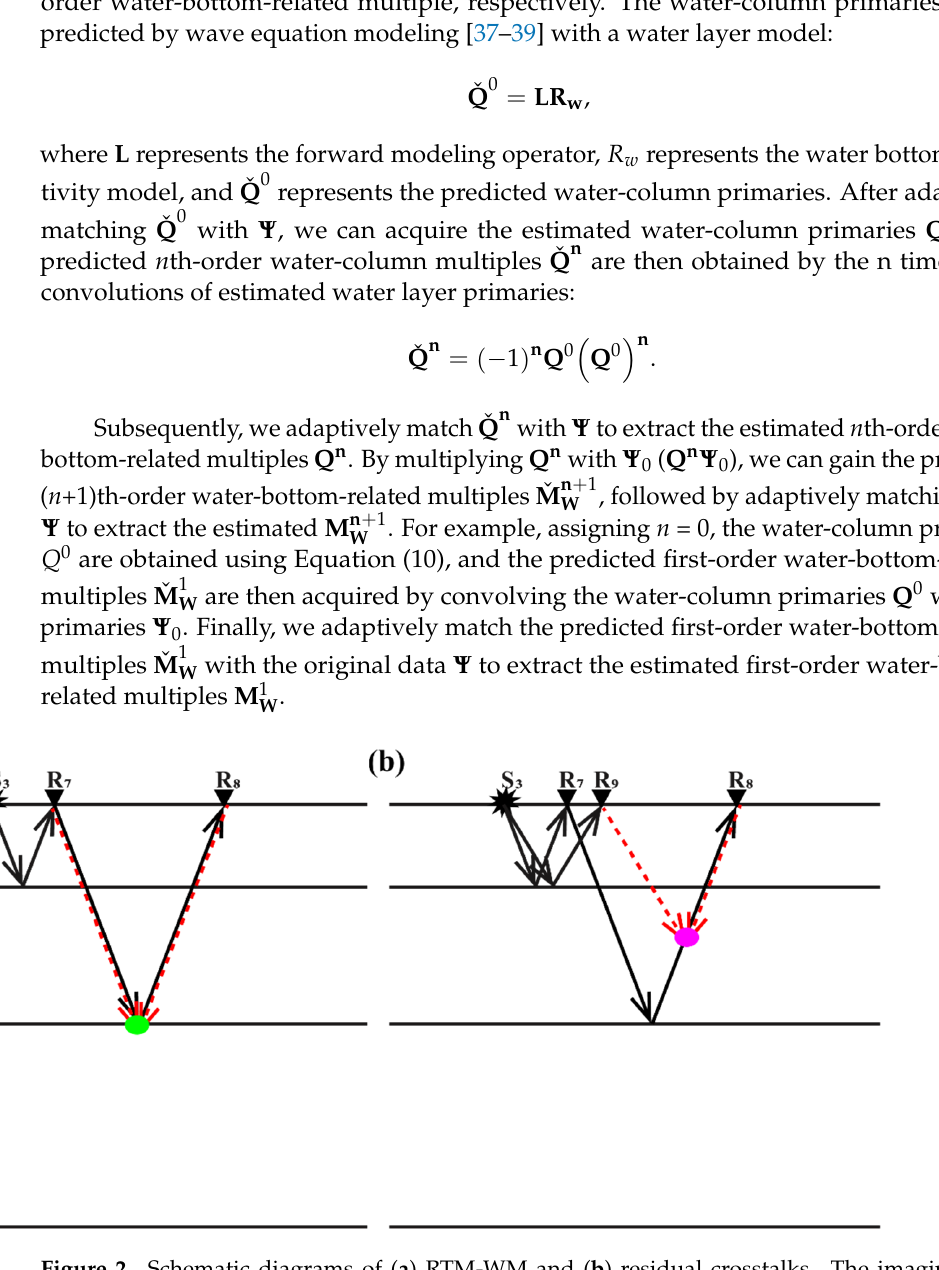
Figure 2. Schematic diagrams of ( a ) RTM-WM and ( b ) residual crosstalks. The imaging point represented by the green point in panel ( a ) is created by the crosscorrelation between the forward-propagating water-column primaries and the backward-propagating first-order water-bottom-related multiples. The magenta point in panel ( b ) indicates the residual non-stationary crosstalks.